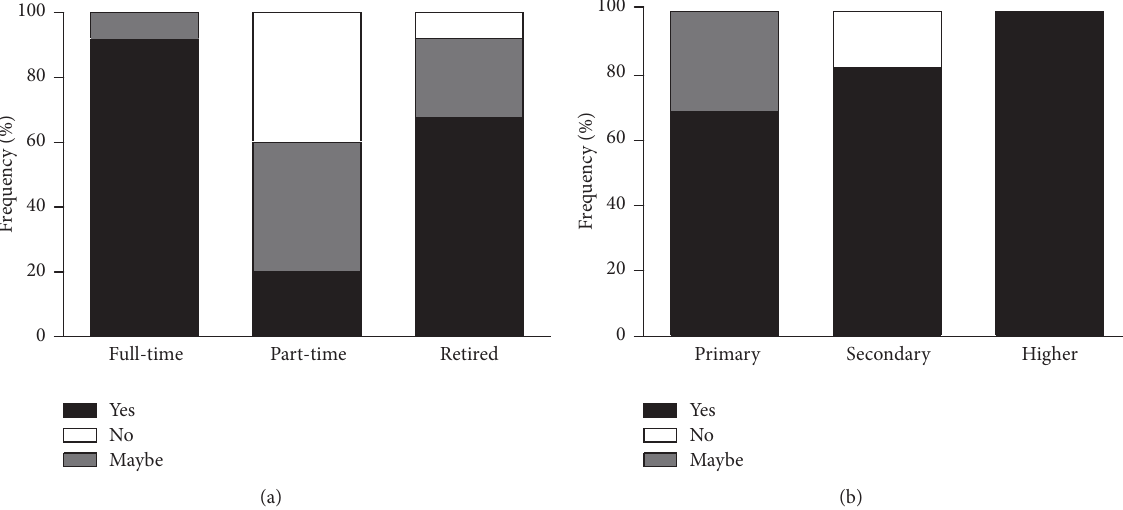
Figure 3: Economic activity in relation to willingness (a) and educational level in relation to satisfaction (b) in participating in fundus screening